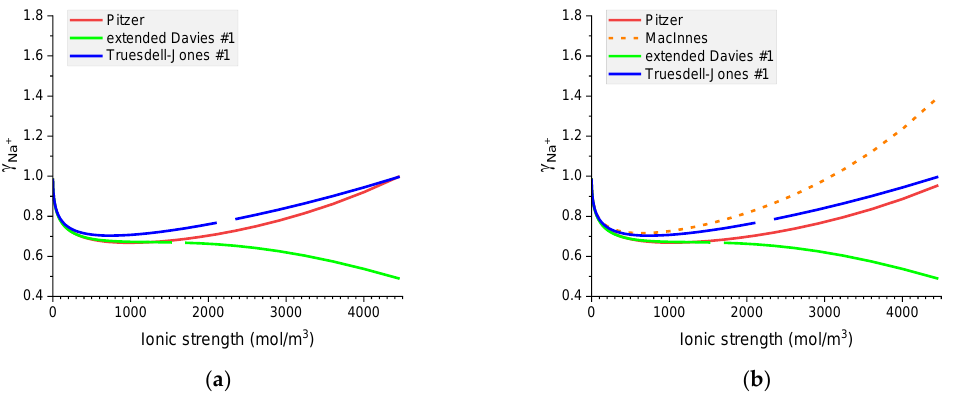
Figure 10. Molar Na + individual activity coefficients in aqueous ( a ) NaOH and ( b ) NaCl solutions. Comparison of calculated activity coefficients based on the Pitzer, MacInnes, extended Davies, and Truesdell – Jones models at 25 °C.